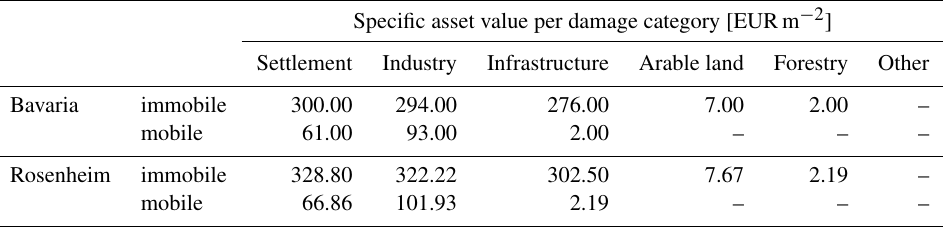
Table 2. Adaptation of the specific asset values stored in the Rhine Atlas model for Bavaria to the case study site Rosenheim.